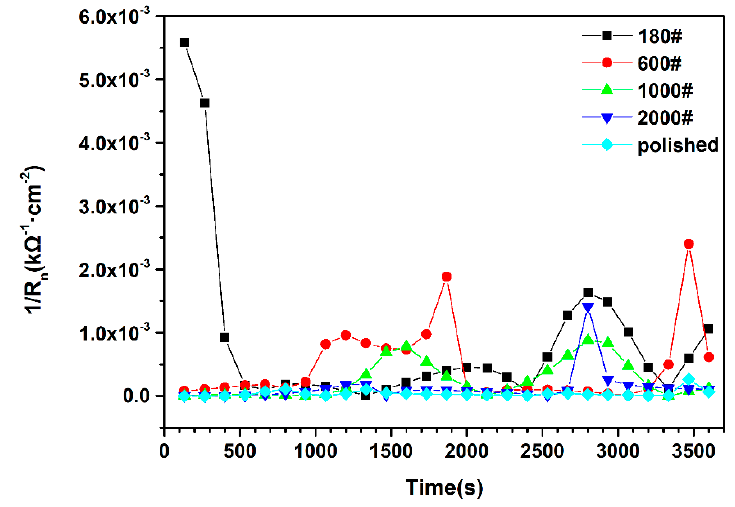
Figure 4. Reciprocal of R n of different surface roughness DSS 2205 samples in 10% FeCl 3 at 50 °C.